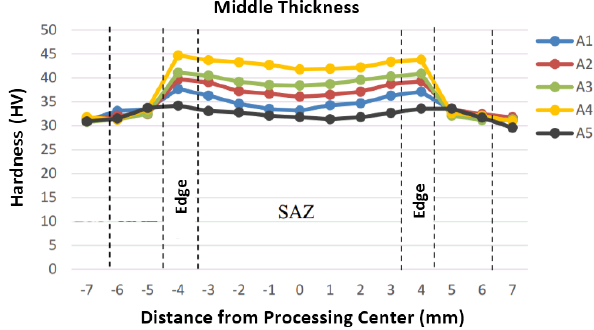
Figure 8: Vickers micro hardness values at middle thickness of friction stir-processed specimen under various Zn particle volumes of 22 mm 3 (A1), 45 mm 3 (A2), 67 mm 3 (A3), 90 mm 3 (A4) and 0 mm